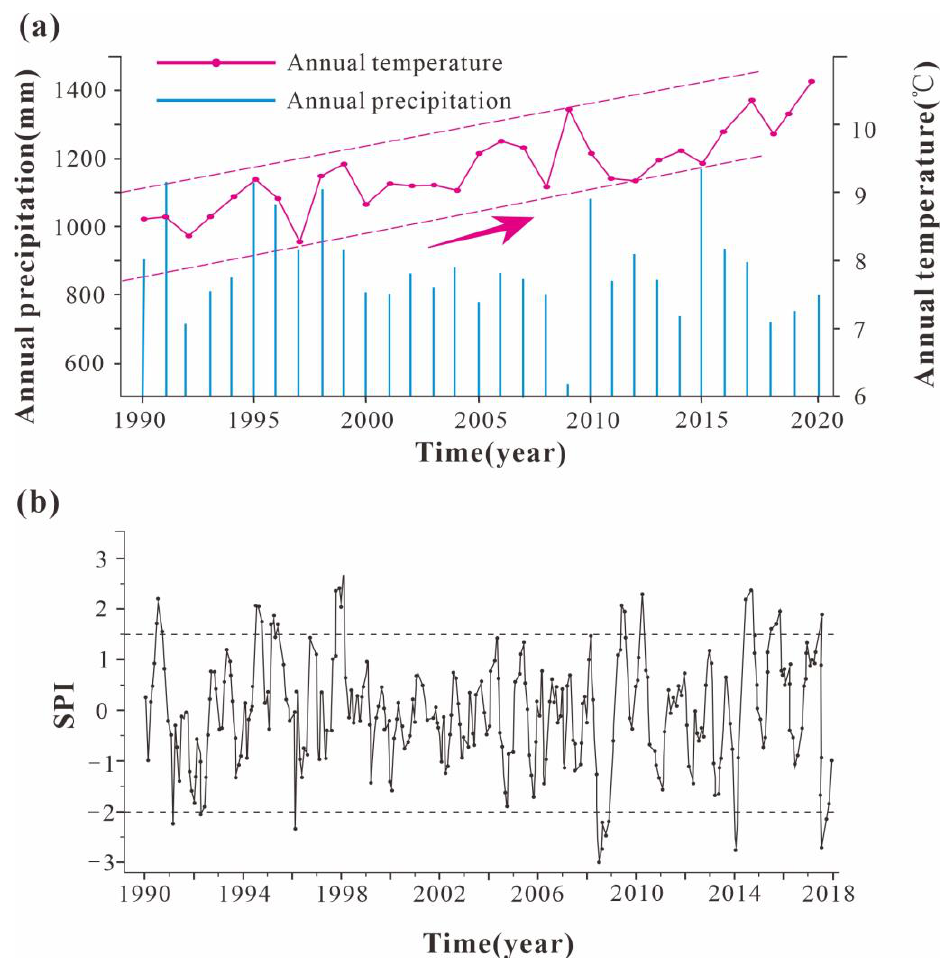
Figure 3. Temperature, rainfall, and dry and wet curves of Yigong landslide. ( a ) The curve of annual average temperature and annual average precipitation; ( b ) The curve of SPI in Yigong landslide.